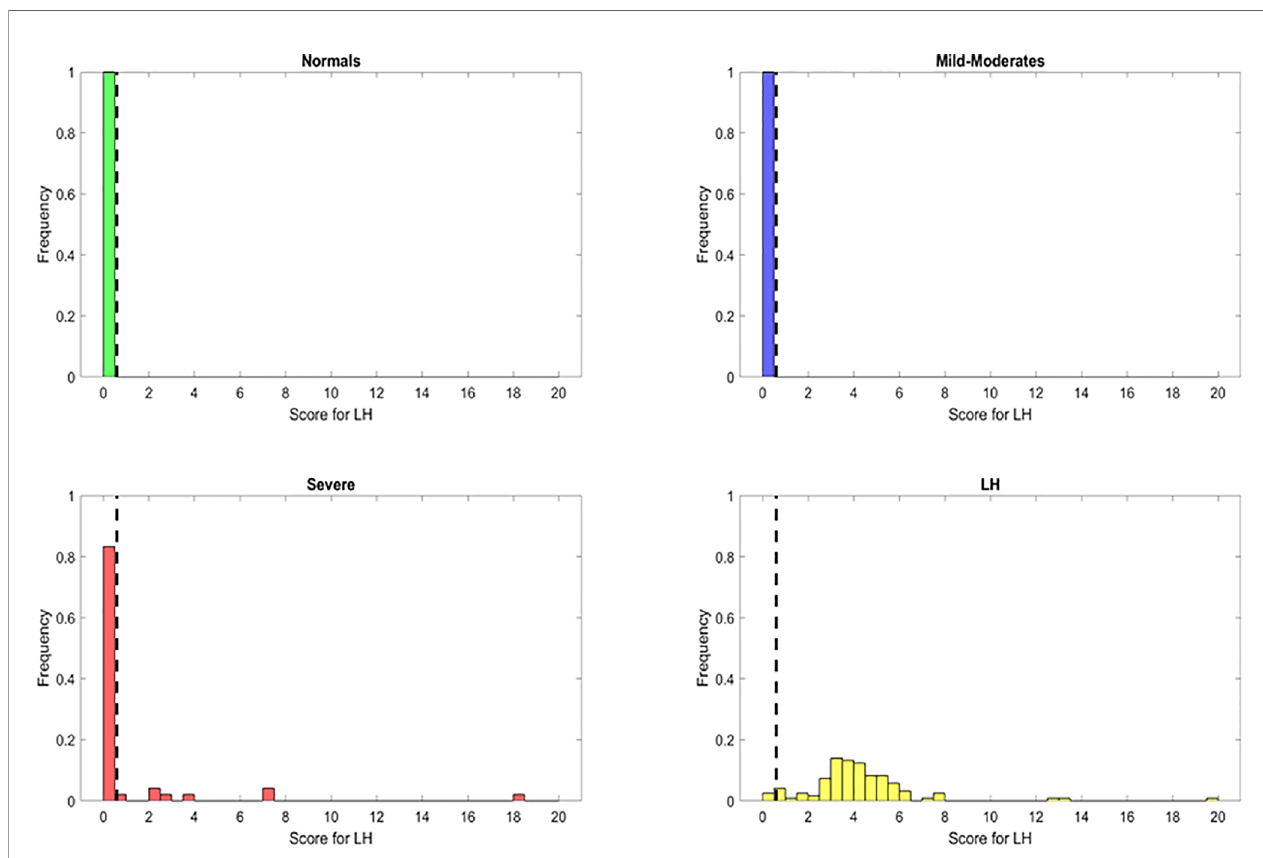
FIGURE 4 | Discrimination ability of the long hauler score for the identi fi cation of PASC patients (S1) with reduced or most important features identi fi ed using Random Forest classi fi er. The dots represent the data points, where yellow are PASCs, red-Severe, dark blue-Mild-Moderate and green-healthy